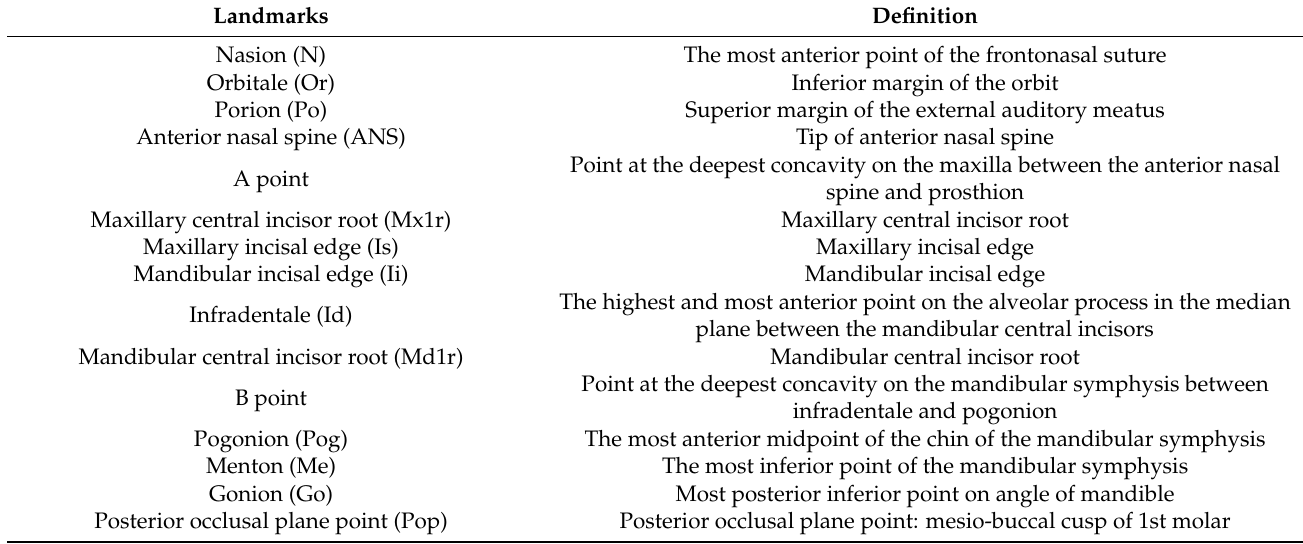
Table 1. Landmark